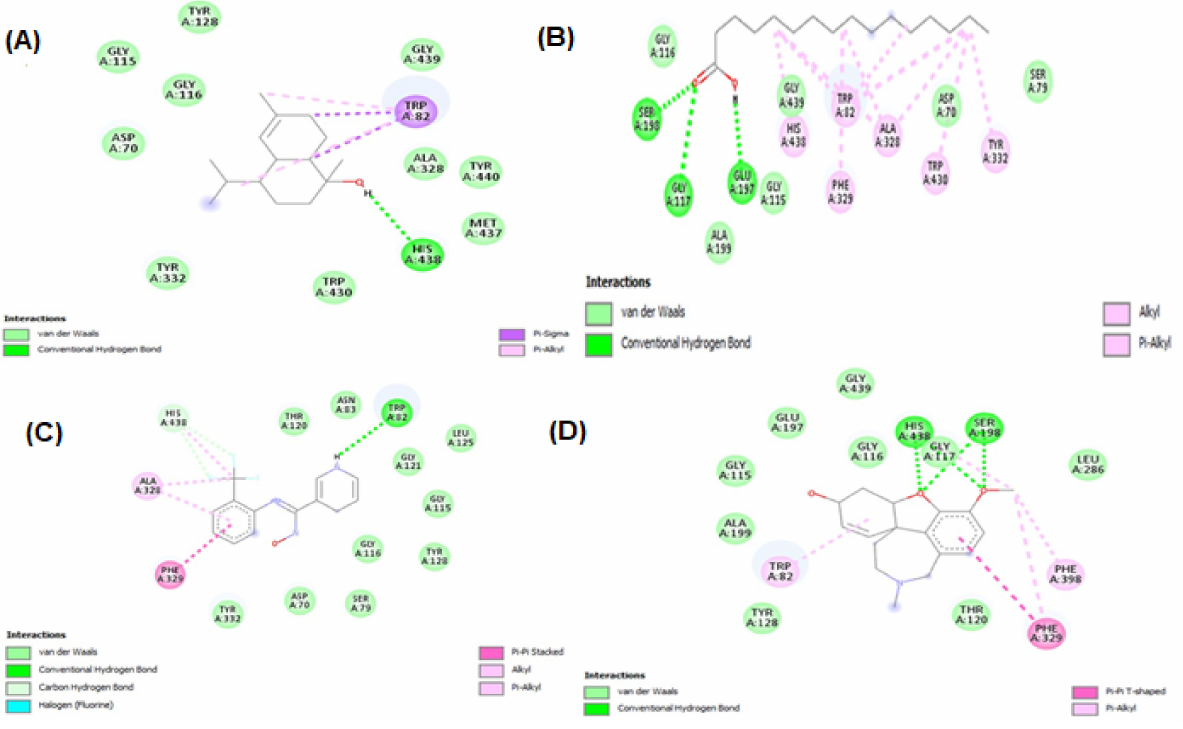
Figure 10. Interaction between butyrylcholinesterase and ligands. ( A ) Alpha–cadinol, ( B ) n- hexadecanoic acid, ( C ) N-hydroxy-N (cid:48) -[2-(trifluoromethyl)phenyl]pyridine-3-carboximidamide, and ( D )